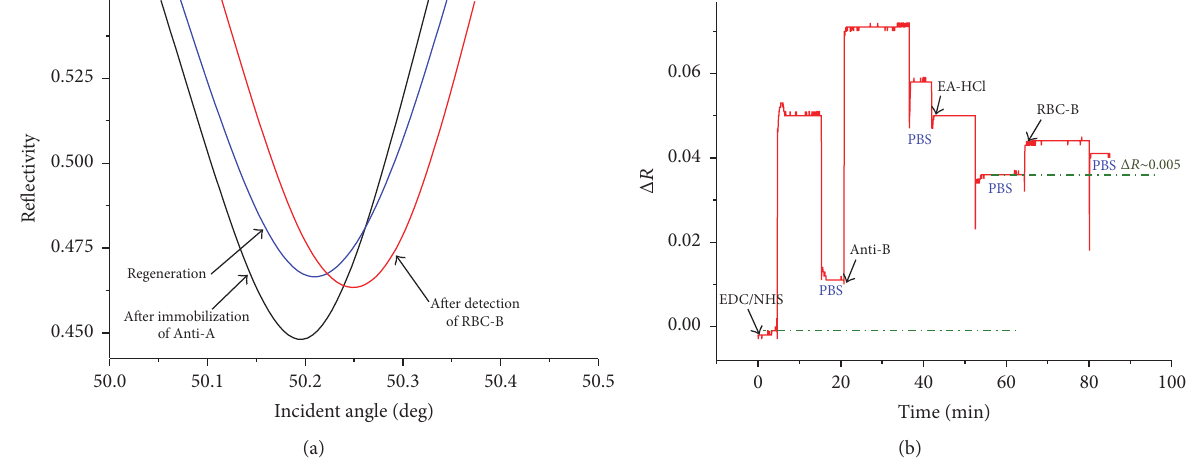
Figure 6: Angular reflectivity curves for LR-SPR after immobilization of Anti-B, after detection of RBC-B, and after regeneration with 20mM NaOH. (b) Corresponding LR-SPR kinetic reflectivity